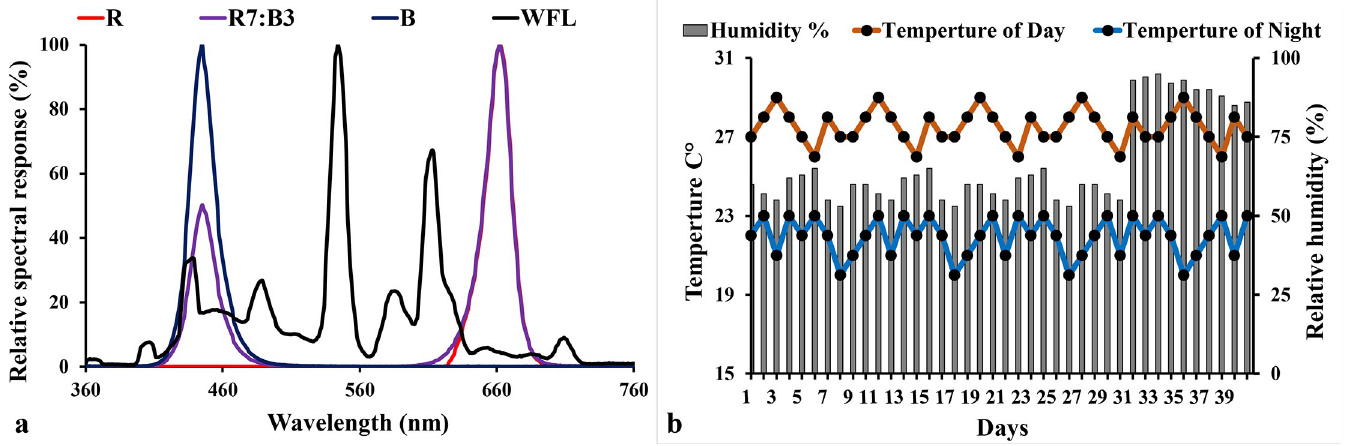
Fig 1. Spectrum distribution of the treatments LED light in the experiment and environmental